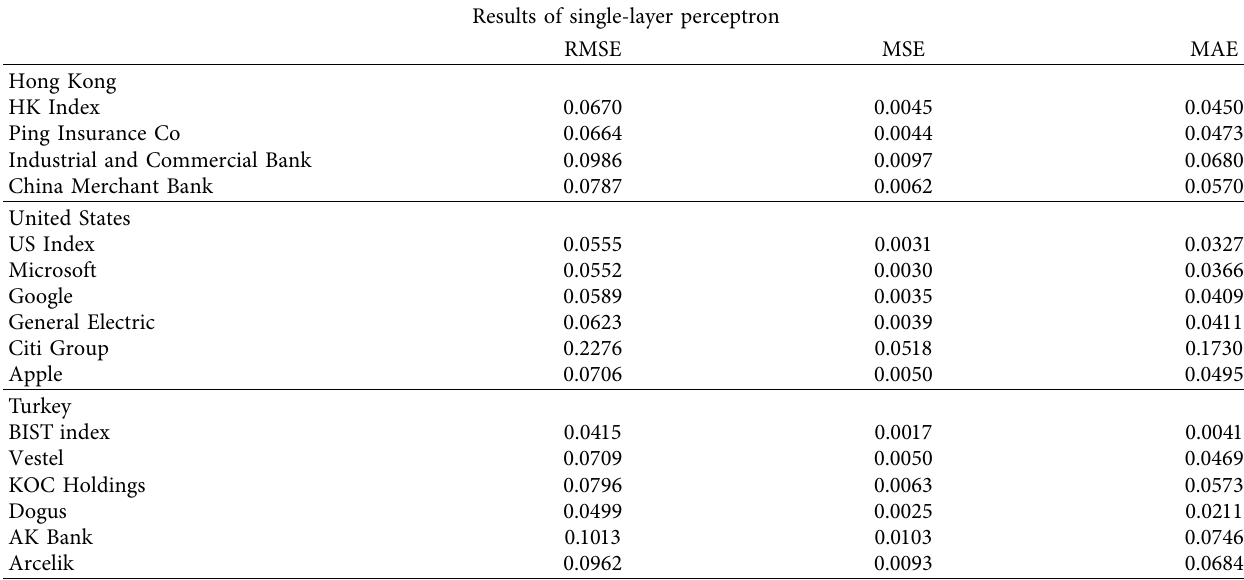
Table 12: Results of single layer perceptron for all companies of Hong Kong, the US, and Turkey without sentiment.